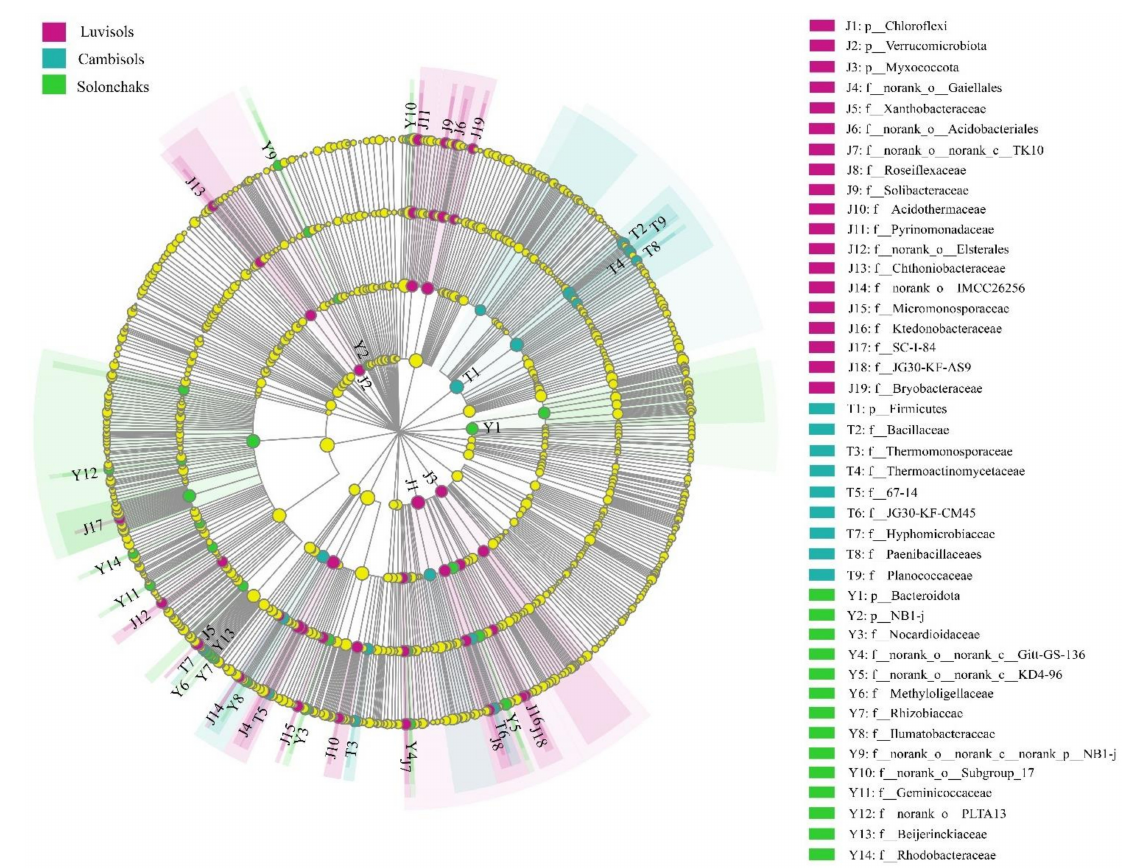
Figure 3. Community difference of LEfSe analysis of rhizosphere bacteria in different soil types of pecan plantations. The LEfSe analysis shows the top 50 species in abundance. Different node colors indicate that microbial species are enriched and significant differences in corresponding groups, while light yellow nodes indicate no significant